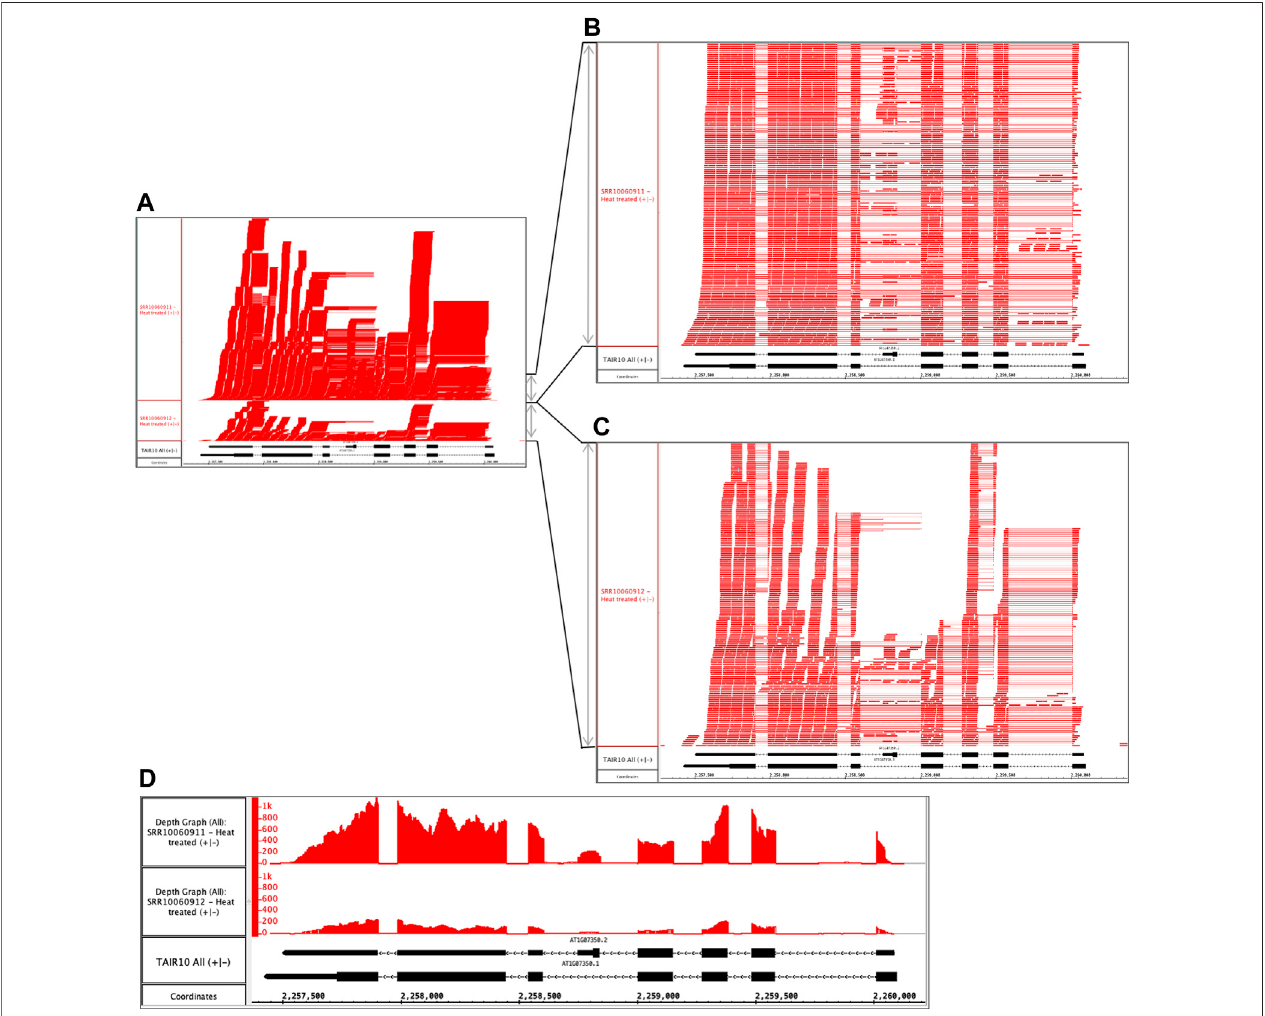
FIGURE 3 | Heat treated samples viewed in IGB. (A) Vertical dimension is compressed to show all alignments. (B) SRR10060911 and (C) SRR10060912 tracks stretched vertically to reveal alignment patterns in more detail. (D) Alignment coverage graphs calculated within IGB using alignments from (A) . The y-axis values represent the number of aligned sequences per base pair position indicated on the coordinates track. The track labeled TAIR10 mRNA shows SR45a gene models AT1G07350.1 and